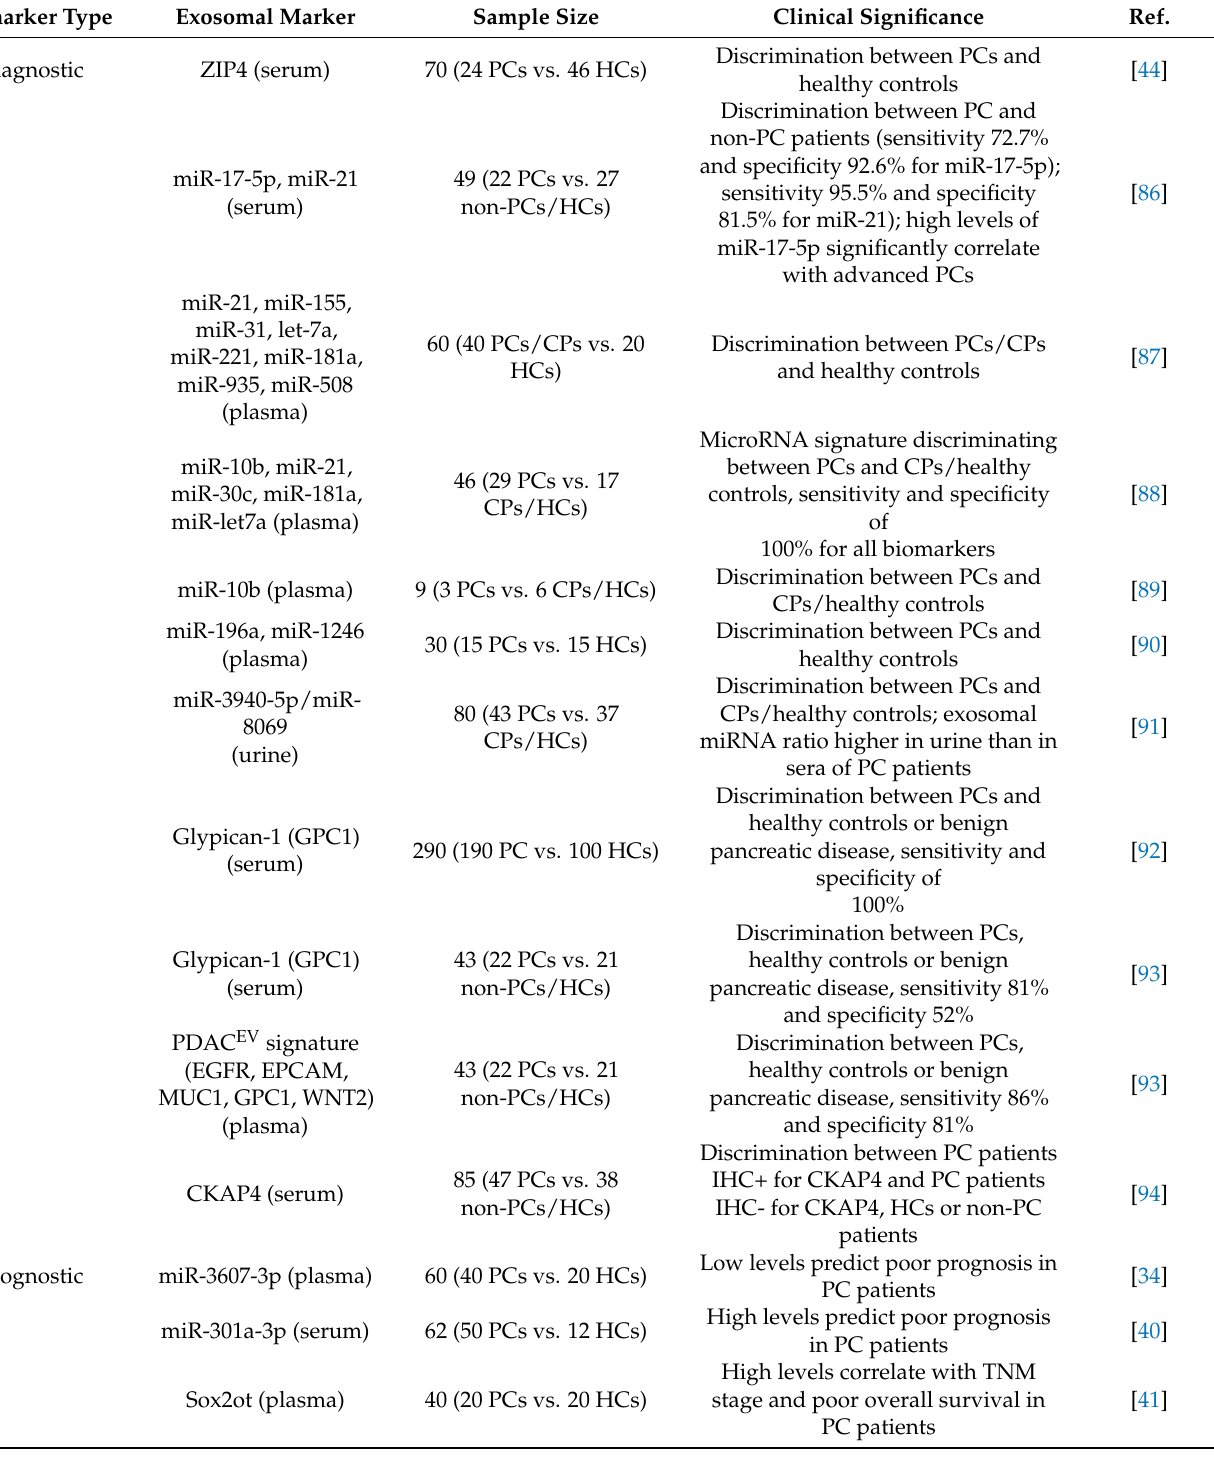
Table 2. Exosomes as diagnostic and prognostic biomarkers for pancreatic